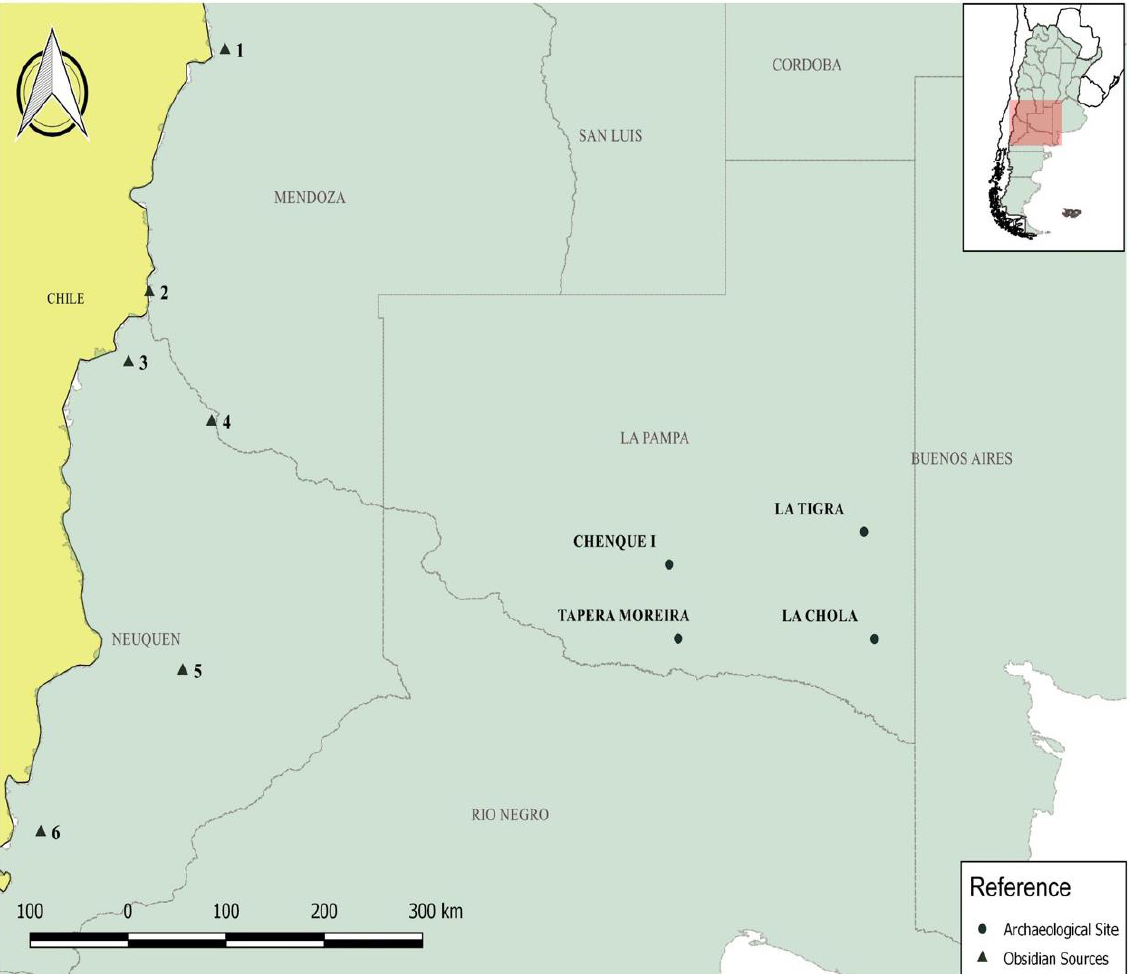
Figure 3. Obsidian sources and archaeological sites location mentioned in this paper. 1-Arroyo Paramillos, 2- Laguna del Maule, 3-Varvarco, 4-Cerro Huenul, 5-Portada Covunco, 6-CP-LL1 (Lake Lolog). 3.1.3. Cerro Huenul (Neuquén